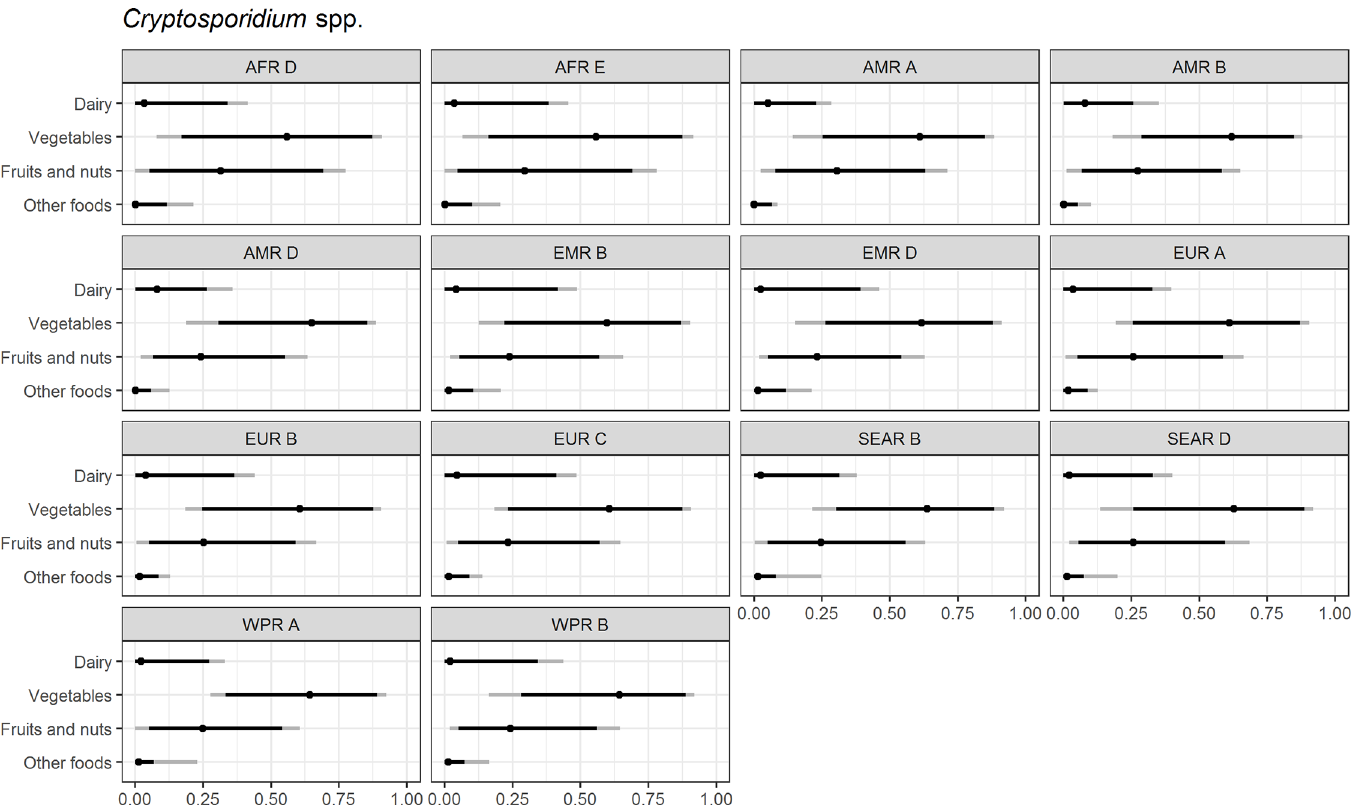
Fig 5. Cryptosporidium spp. Proportion of foodborne disease attributable to specific foods: Median estimate, and 90% and 95% uncertainty intervals by parasite and subregion. “Small ruminants’ meat” was listed as “Goat, lamb and other small ruminants’ meat” in the expert elicitation instrument. The X-axis labels are percentages. The dot represents the medianestimate; the dark black line, the 90% uncertainty interval; and the gray line the 95% uncertainty interval.